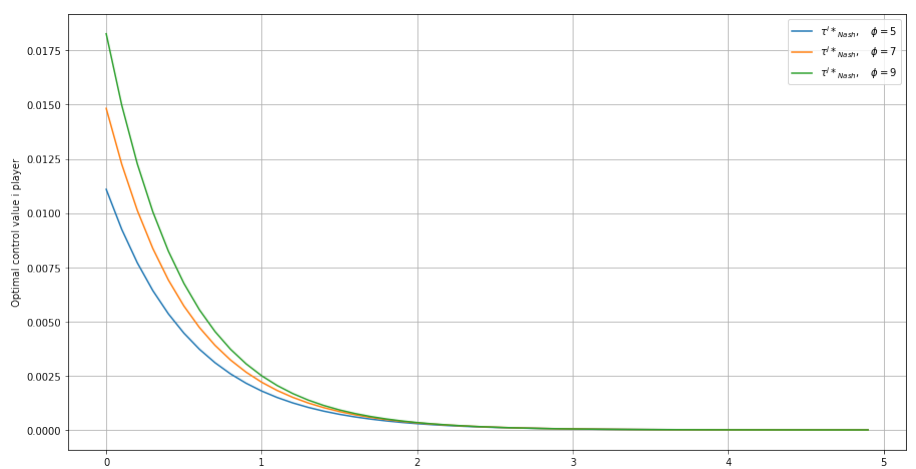
Figure 6. The optimal controls of player i under Nash equilibrium and different φ .